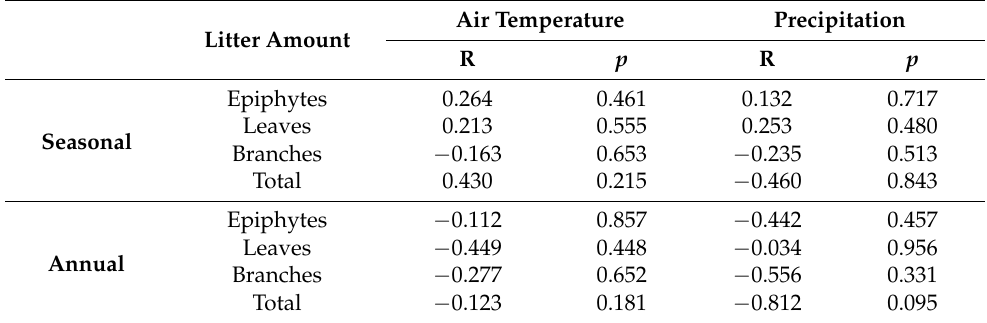
Table 1. Correlation between the amount of litterfall and air temperature and